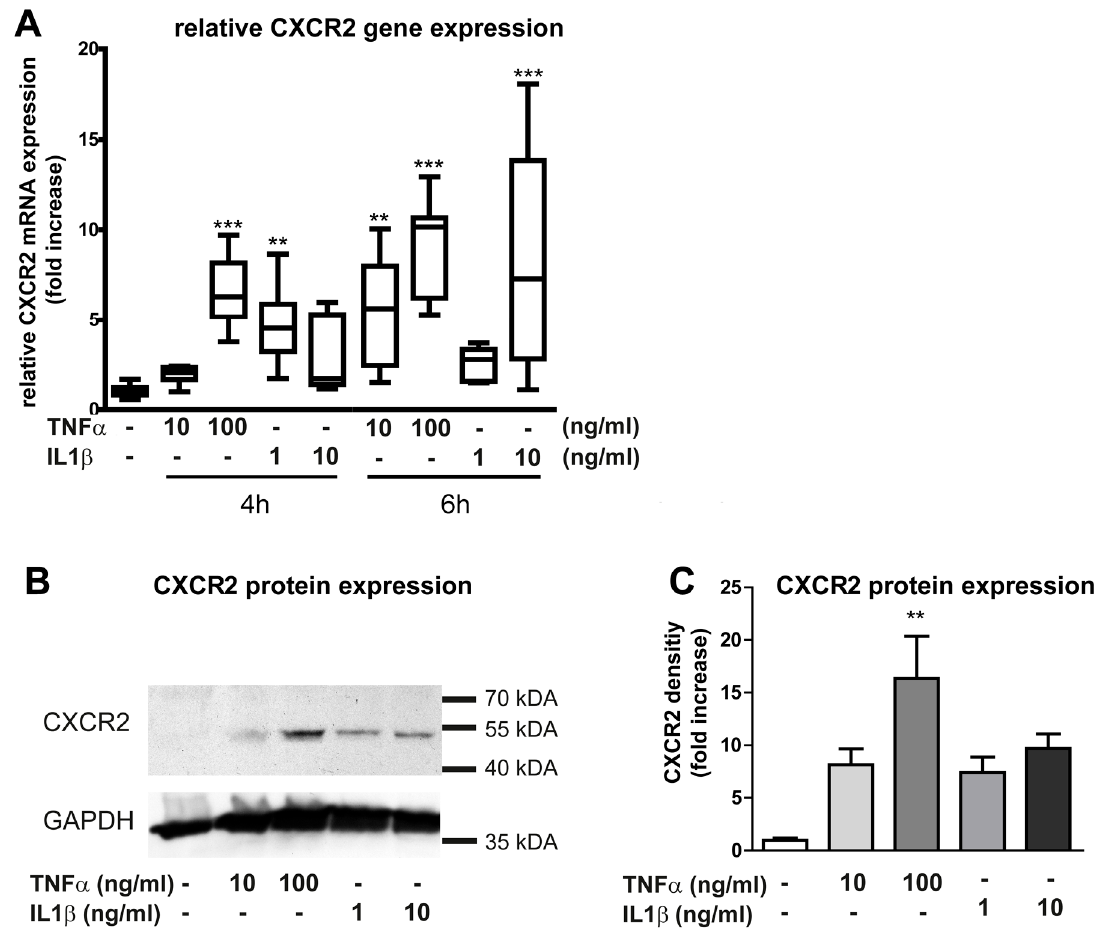
Figure 1. Basal and inflammation-induced CXCR2 expression in human brain endothelium. ( A ) Comparative analysis of CXCR2 mRNA levels by quantitative real-time PCR in hCMEC/D3 after exposure to TNF α or IL1 β for 4 or 6 h. Boxplot and whiskers (min to max) of four independent experiments. Statistical analysis by Kruskal–Wallis test followed by Dunn’s post-test. ( B ) Representative example of immunoblotting for CXCR2 protein of hCMEC/D3 whole cell protein extracts after stimulation of cells with TNF α or IL1 β for 6 h. Anti-GAPDH (glyceraldehyde-3-phosphate